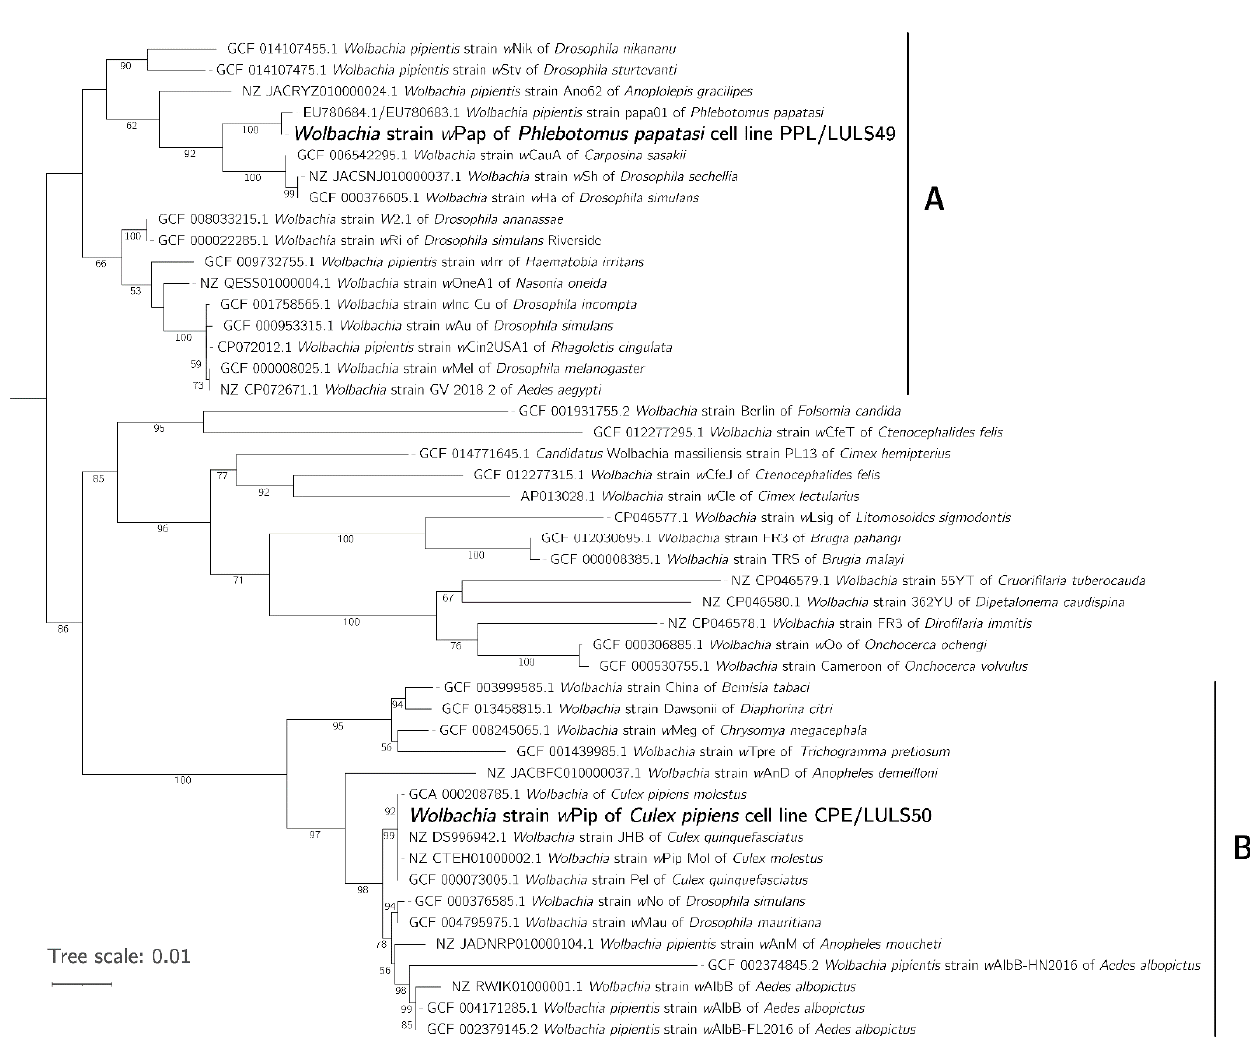
Figure 3. Phylogenetic analysis of the Wolbachia strains w Pip and w Pap isolated in cell lines CPE/LULS50 and PPL/LULS49, respectively. Concatenated phylogenetic tree generated from 16S rRNA and wsp sequences obtained in the present study (in bold ) and previously published in GenBank, showing the accession numbers and host species. Supergroups A and B are indicated by capital letters to the right of the tree. Table 2. Infectivity of the Wolbachia strains w Pip and w Pap for heterologous tick and insect cell